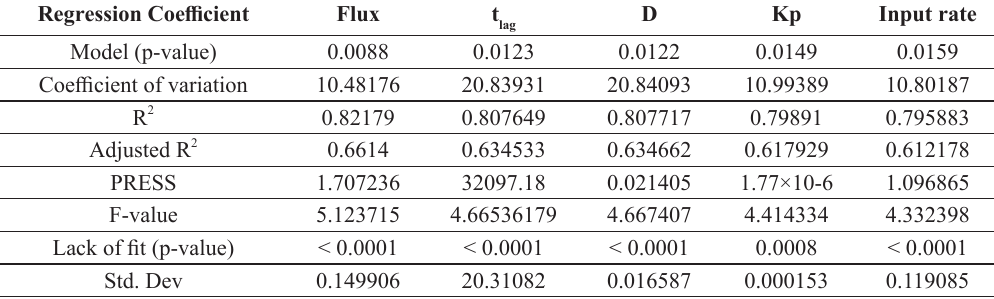
Regression Analysis and Their Value of all Five